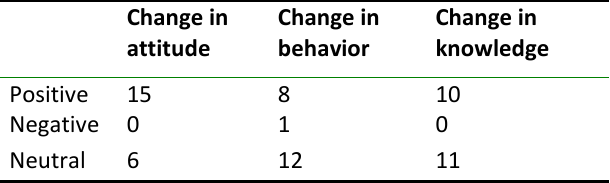
Table 1 . Study on gamification effectiveness in changes in attitude, behavior and